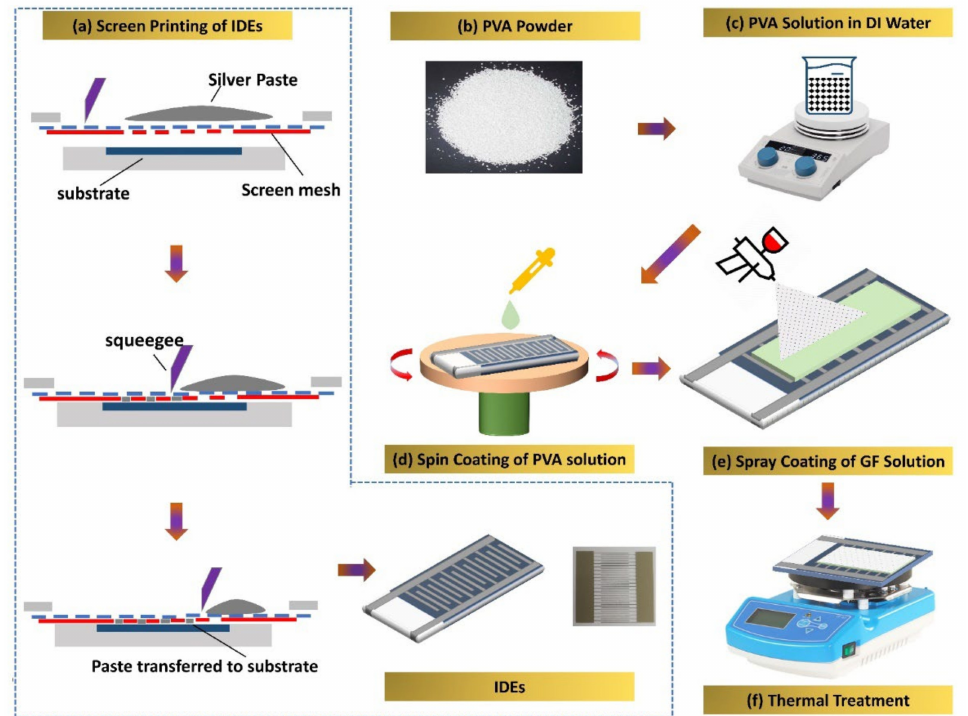
Figure 1. ( a ) Screen printing of Inter Digitated Electrodes over the PET substrate, ( b ) PVA powder, ( c ) PVA solution in the DI water, ( d ) spin coating of PVA solution on electrodes, ( e ) spray coating of graphene flower solution on the PVA-coated IDEs, ( f ) annealing of the active sensing layer of the